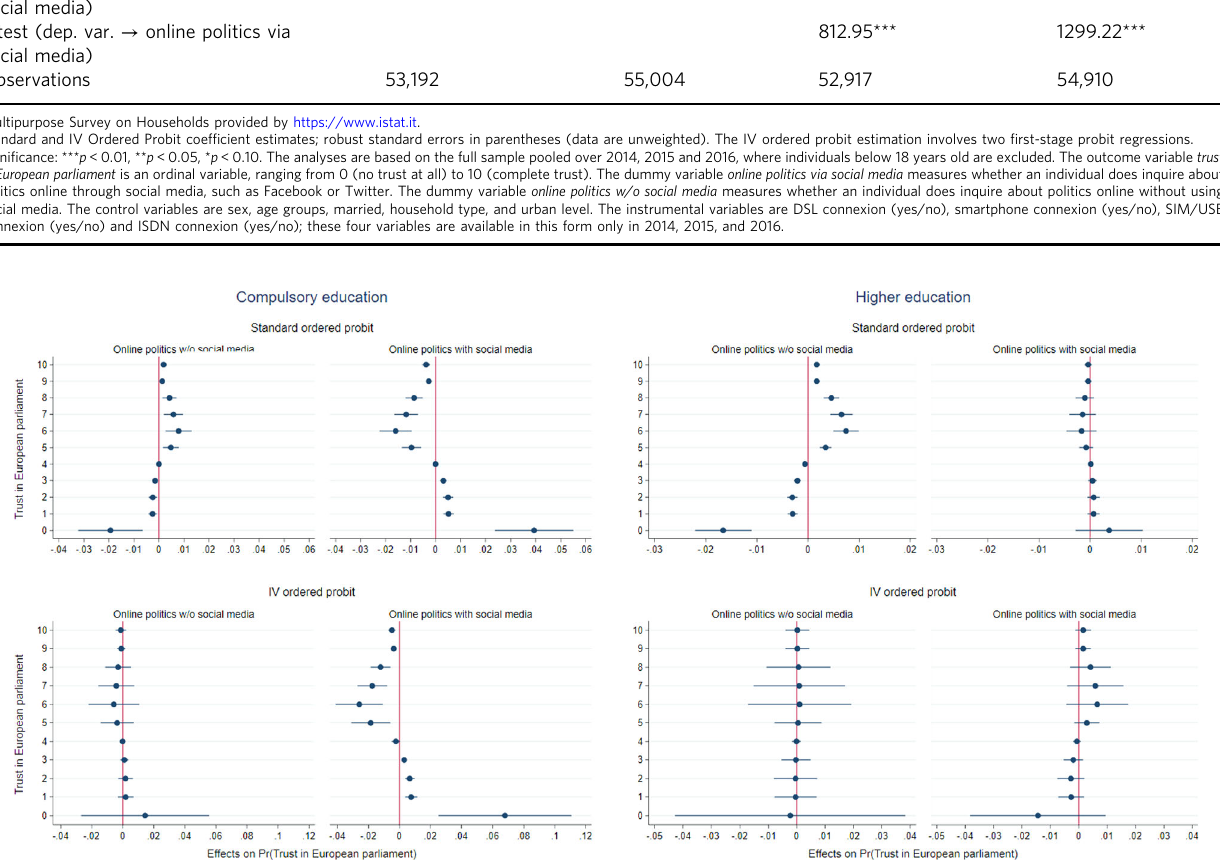
Fig. 3 Average marginal effects of online politics by level of education. Note: Calculation from Table 4. The average marginal effects are plotted with the 95 percent con fi dence